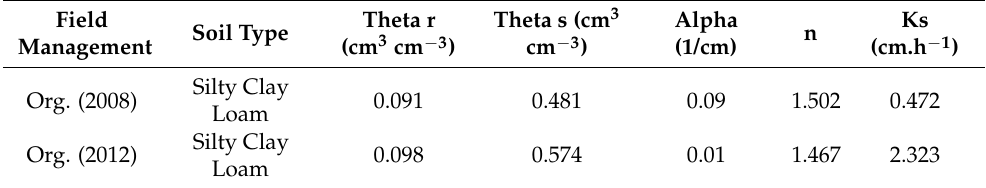
Table 4. Hydraulic properties of sampled soils under organic farming in 2008 and